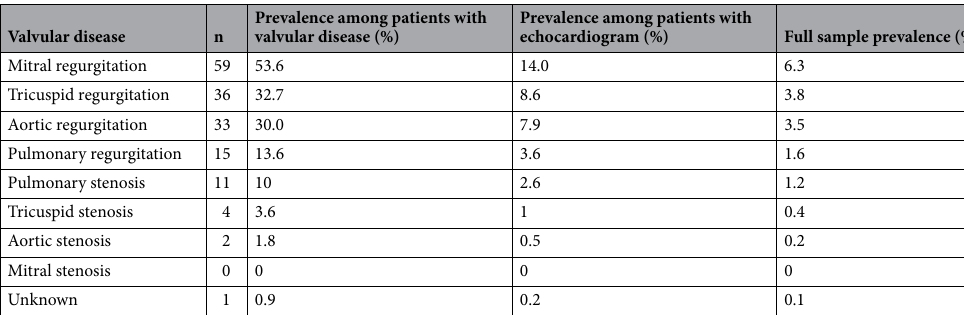
Table 3. Prevalence of valvular heart disease in Spanish adults with Down